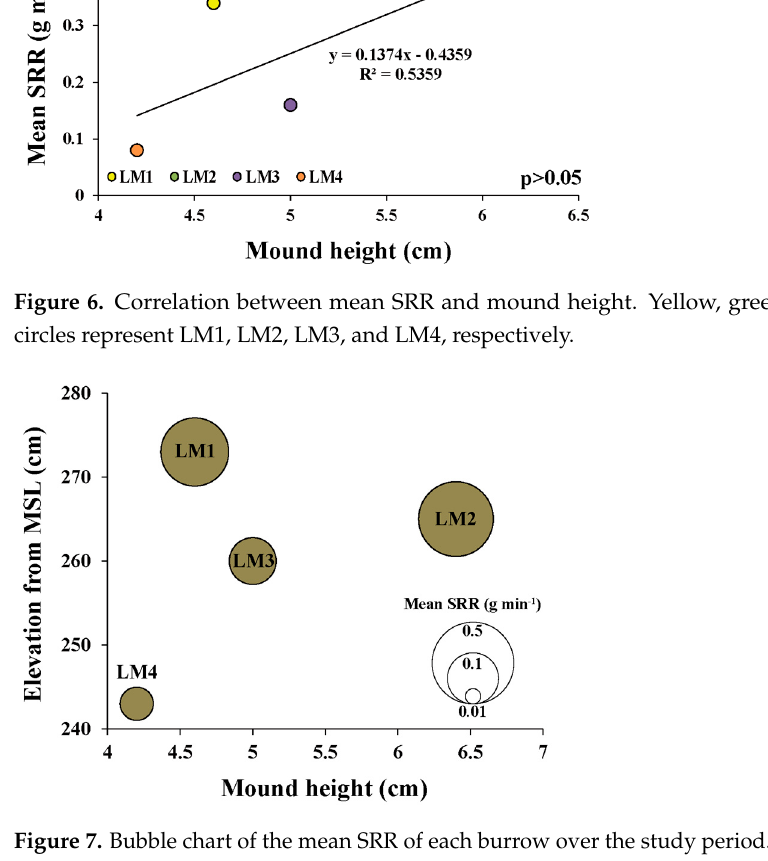
Figure 7. Bubble chart of the mean SRR of each burrow over the study period. Bubble size represents the mean SRR of each burrow.